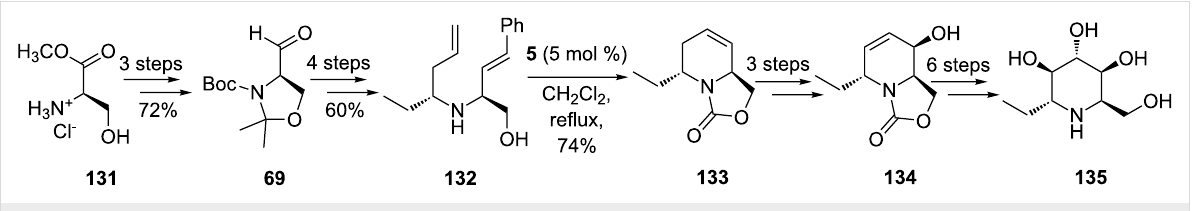
Scheme 23: Total synthesis of (+)-adenophorine ( 135